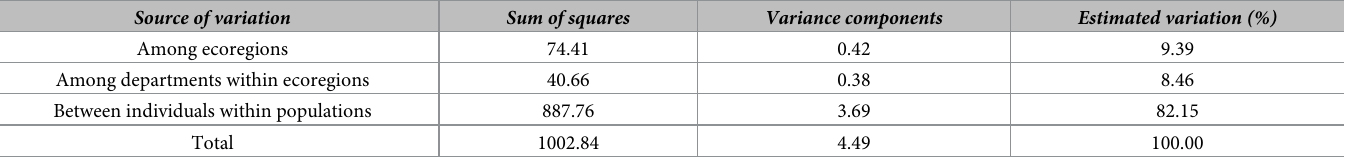
Table 4. Analysis of Molecular Variance (AMOVA) for L . (V . ) braziliensis population. Source of variation